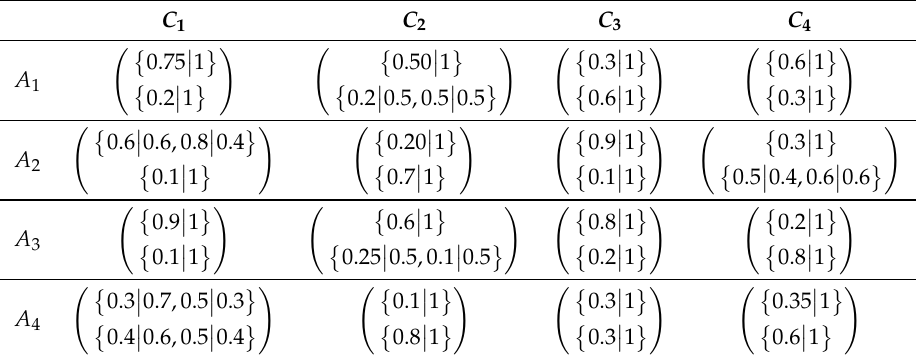
Table 3. Preference values provided by decision-maker